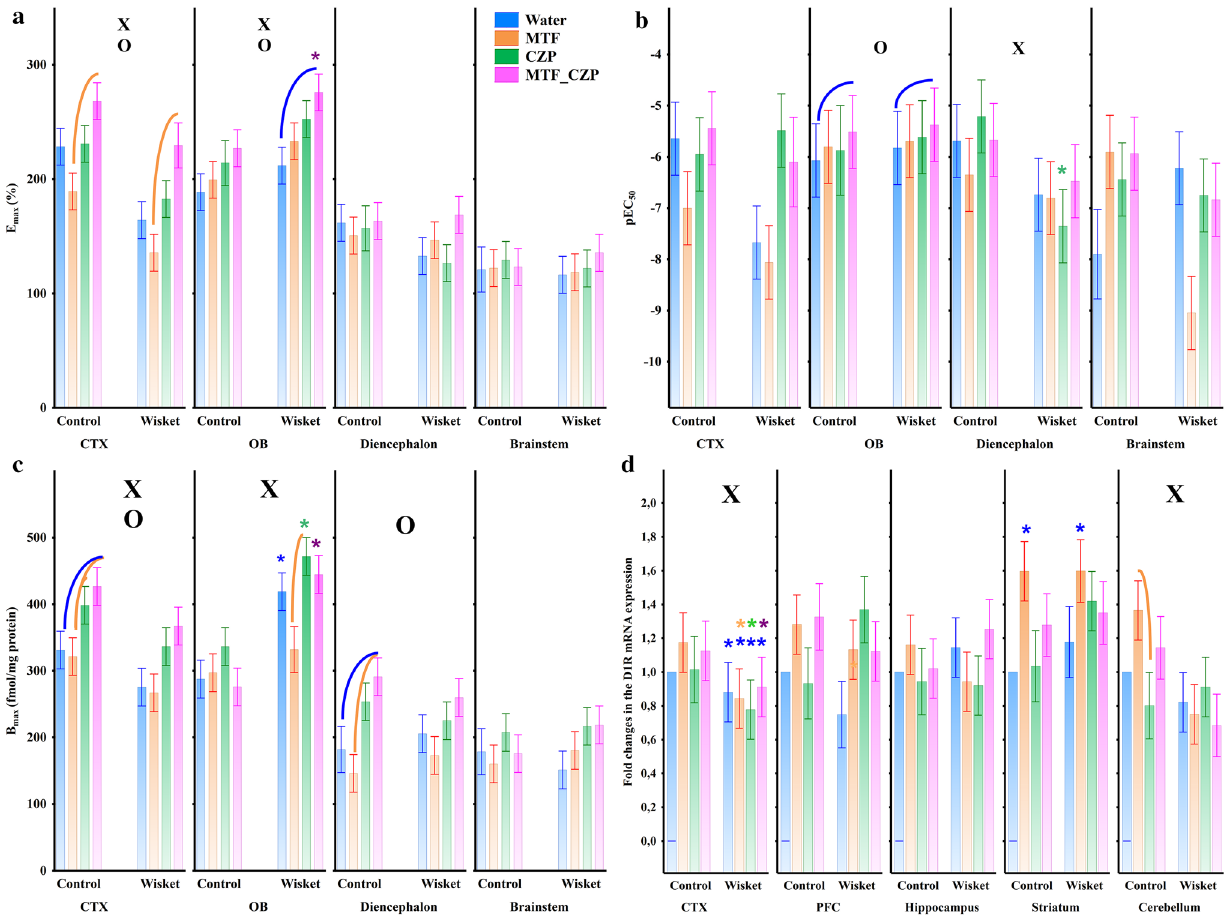
Figure 4. Results of D 1 R signaling, binding, and mRNA expression assays, as indicated by the changes in E max ( a ), pEC 50 ( b ), and B max ( c ) values and mRNA expression ( d ) in the different rat brain structures. The symbols indicate significant effects of group (X) and treatment (O). The symbols also indicate post hoc significant differences between groups (*) and treatments (arc). The blue stars pinpoint significant differences compared with the water-drinking Wistar rats, whereas the remaining stars indicate significant differences compared with the control matched pairs. Abbreviations: CTX, cerebral cortex; OB, olfactory bulb; PFC, prefrontal